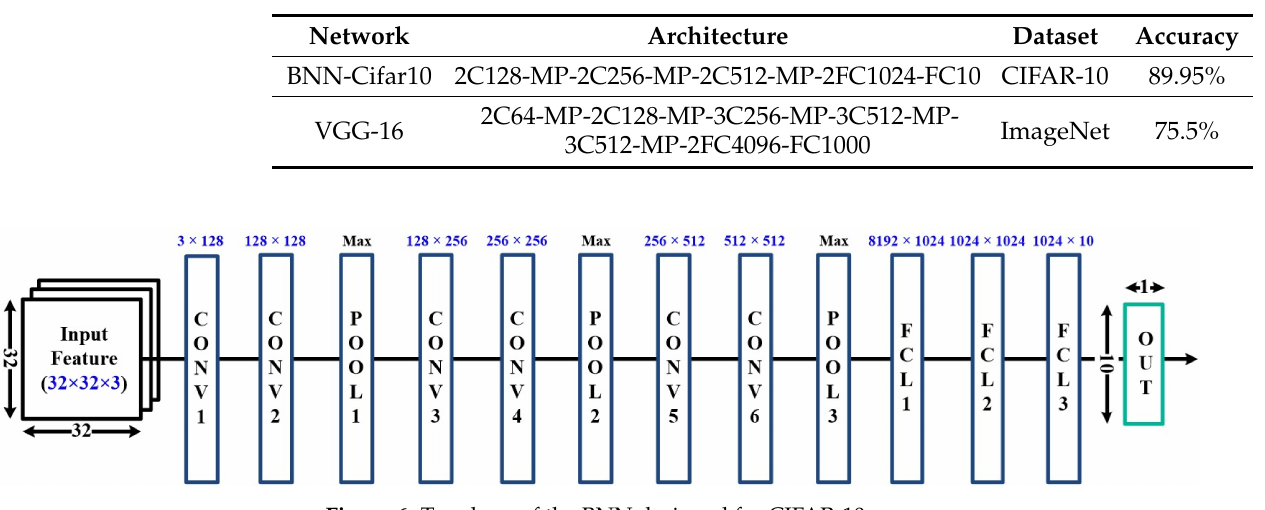
Figure 6. Topology of the BNN designed for